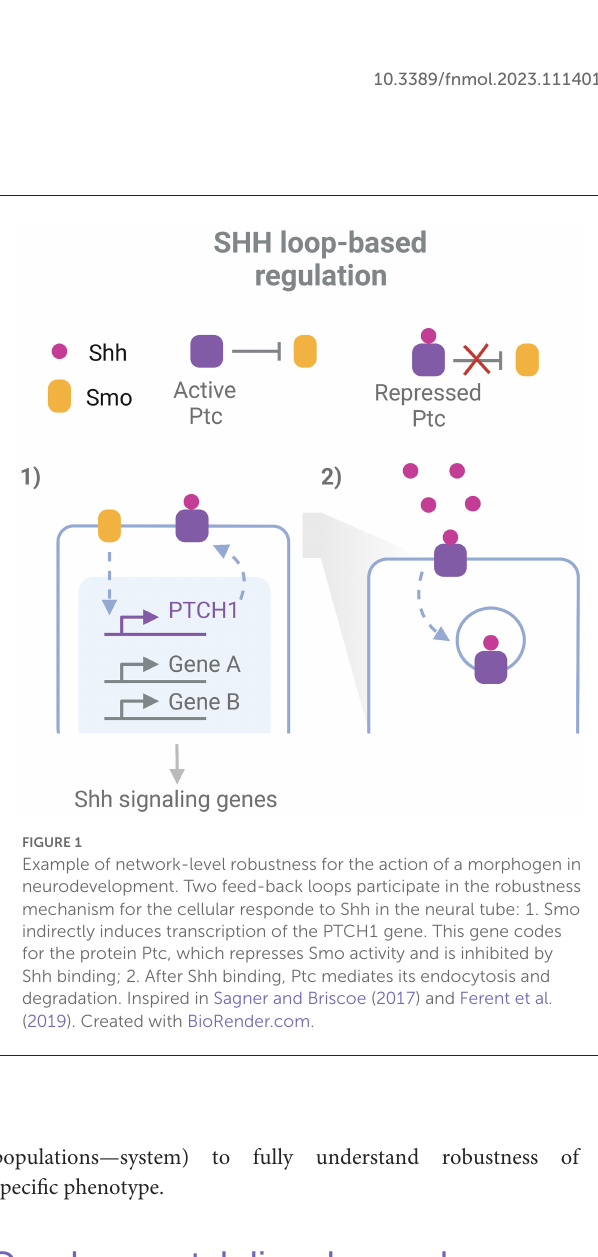
populations—system) to fully understand robustness of a specific